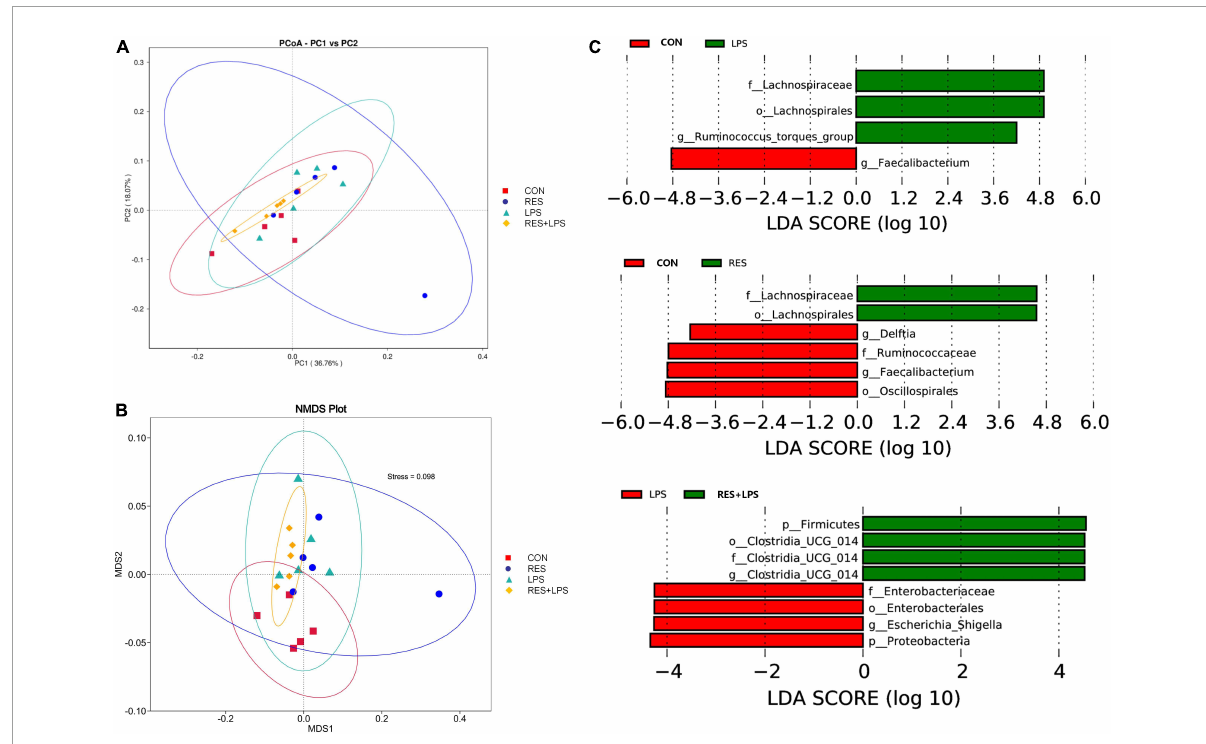
FIGURE5 The effect of dietary resveratrol supplementation on the beta-diversity of cecal microbiota in yellow-feathered broilers. (A) The principal coordinate analysis (PCoA) plot; (B) Non-metric multidimensional scaling (NMDS) plot. (C) The LEfSe analysis (LDA score > 4). CON, control; RES, resveratrol; LPS, lipopolysaccharide; RES + LPS, dietary resveratrol treatment followed by LPS challenge.